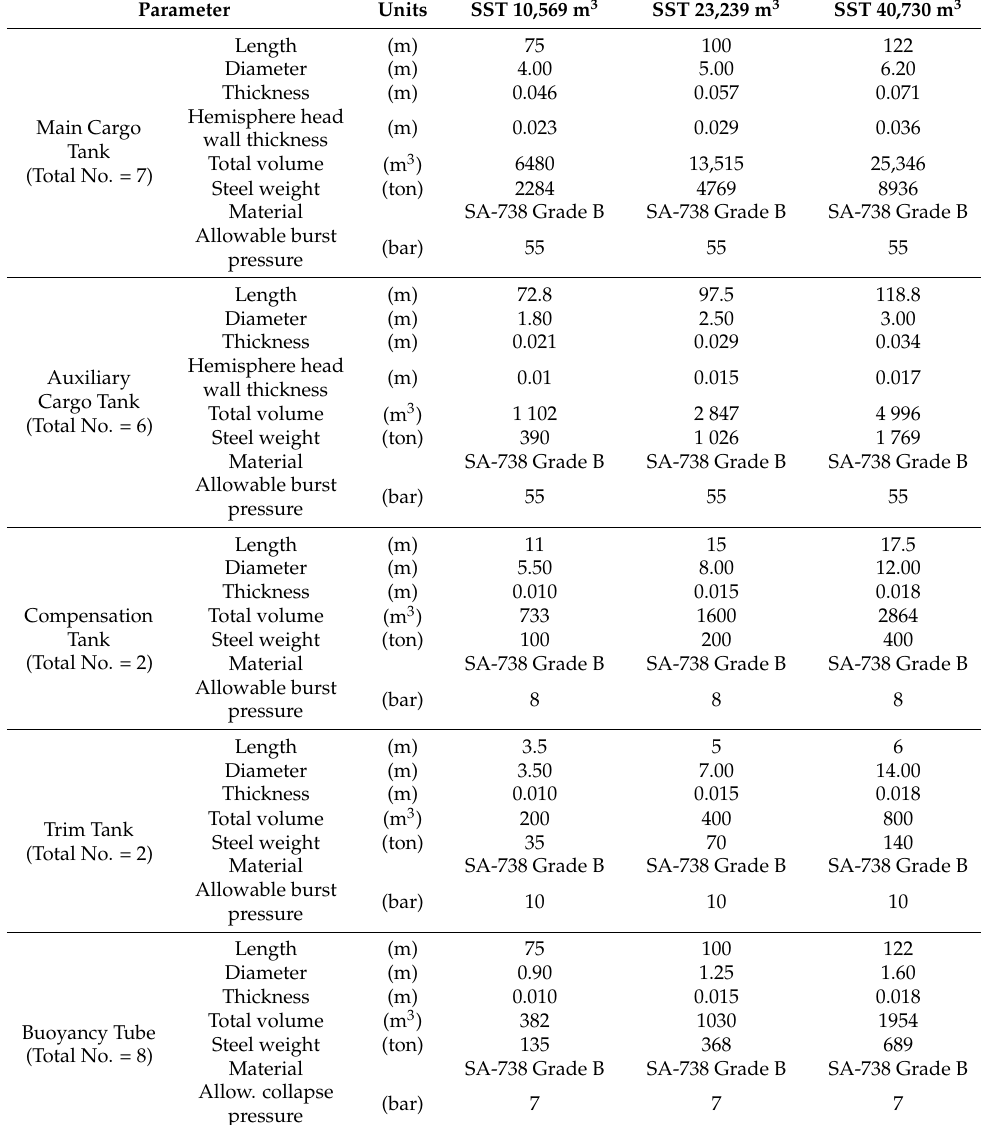
Table 5. SST internal tank